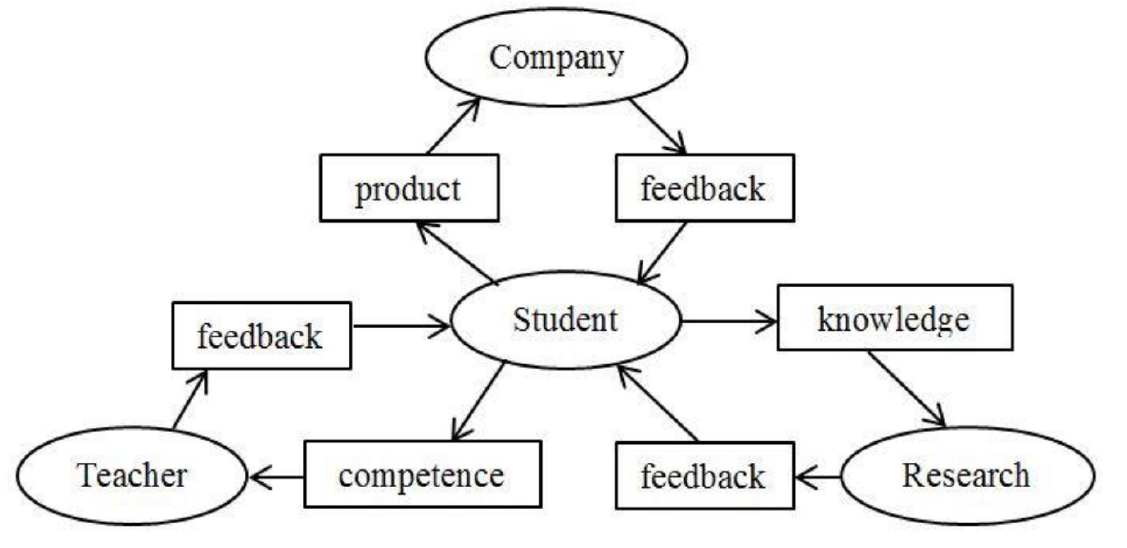
Figure 1. Triple Helix Learning Environment model